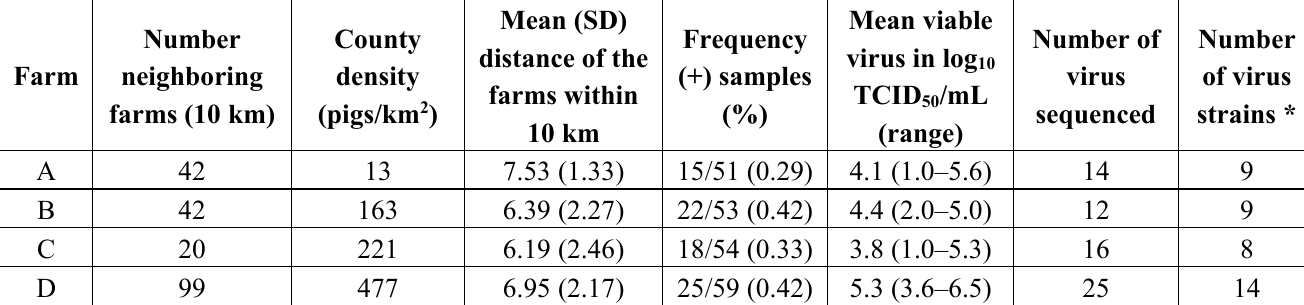
Table 1. Summary of virus collection frequency, concentration, and strain diversity in each of the air sampling collection sites.